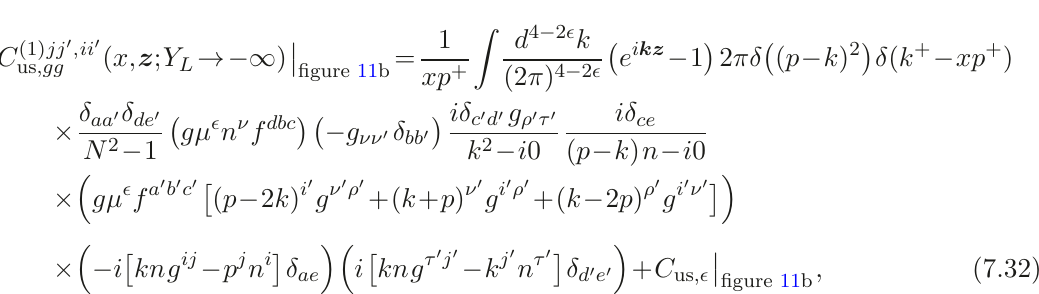
Figure 11. Real graphs contributing to the matrix elements Not shown are the complex conjugates of graphs (b) and